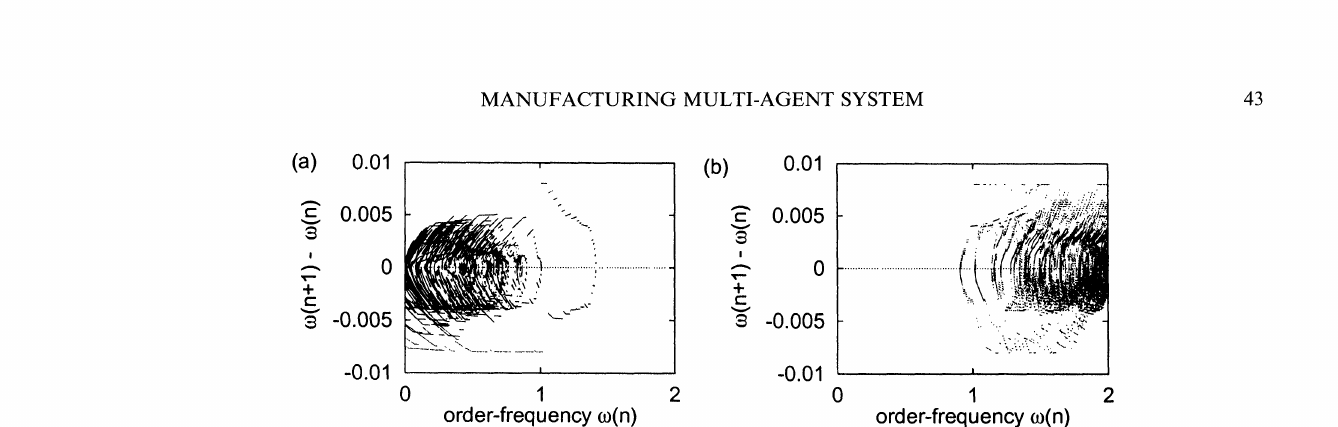
FIGURE 5 Phase portraits of the order frequency co(n) at different productivities of the robotic units. Parameter values: C 1, pl(O)--O, /92(0)--0,